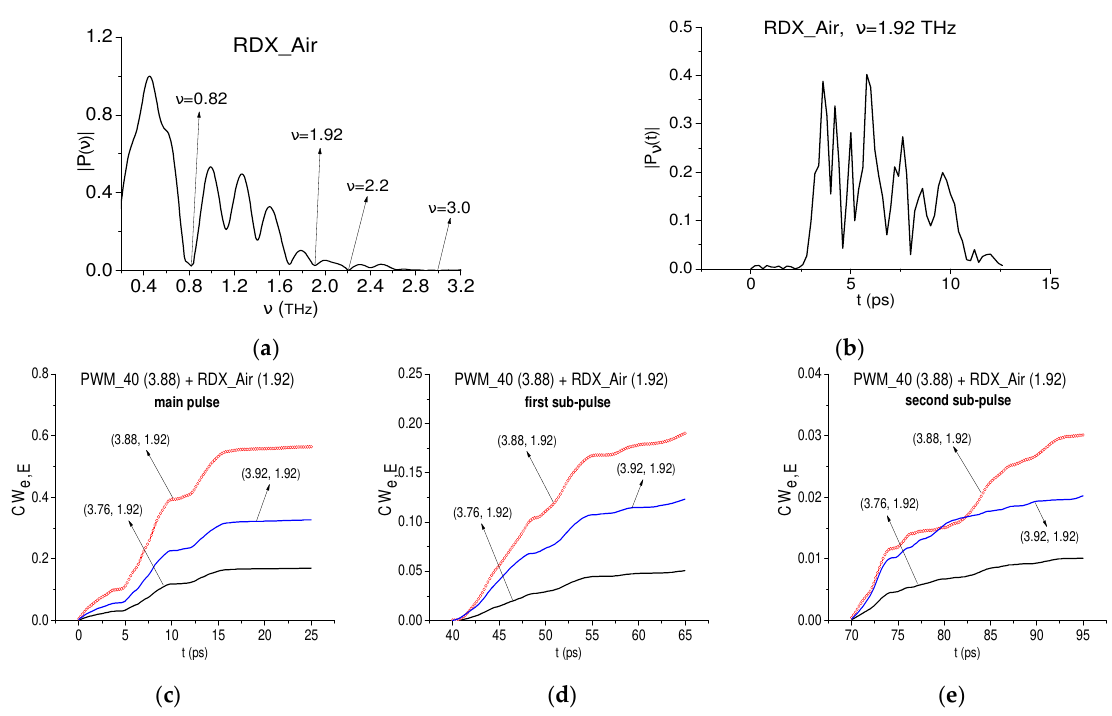
Figure 16. Fourier spectrum of the standard THz signal RDX_Air ( a ) and spectral line dynamics at the frequency ν = 1.92 THz ( b ). Evolution of the ICC CW 1 e , E computed for the PWM_40 spectral line dynamics at the doubled absorption frequency ν = 3.88 THz and the standard RDX_Air spectral line dynamics at the frequency ν = 1.92 THz in the time intervals t = [0, 25] ps ( c ), [40, 65] ps ( d ), [70, 95] ps ( e ). The evolution of the corresponding ICC CW 1 is shown in the time intervals t = [0, 25] ps, e , E [40, 65] ps and [70, 95] ps (Figure 16c–e, respectively). The FDR (see Section 3) is common for all three time intervals, and is equal to ν = [3.76, 3.92] THz. In all cases, we see